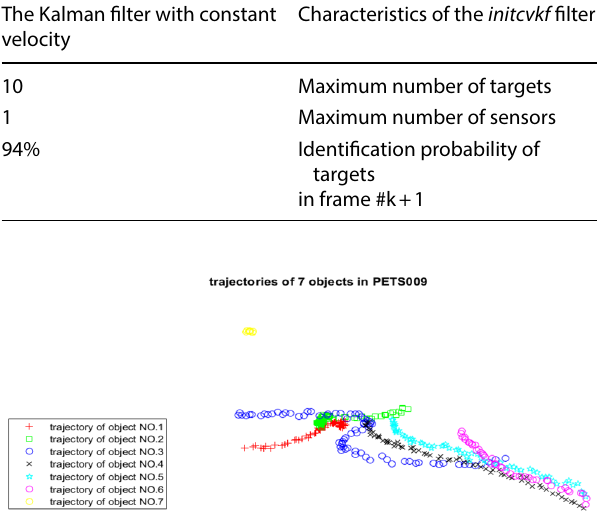
Fig. 6 Trajectories of 7 targets at the first eight seconds of S2.L1 scenario of PETS2009 Table 5 Characteristics of 7 targets at the first eight seconds of S2.L1 scenario Initial value of